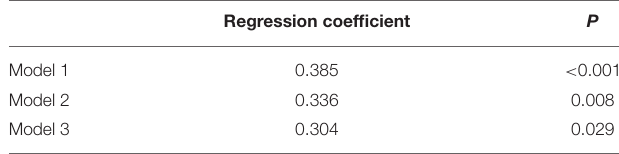
TABLE 2 | Clinical correlations between irisin and various characteristics in VD. TABLE 3 | Association between irisin and MoCA scores in